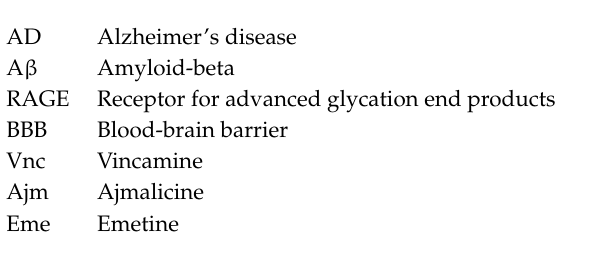
Supplementary Materials: Table S1: Human Intestinal Absorption (HIA) value of